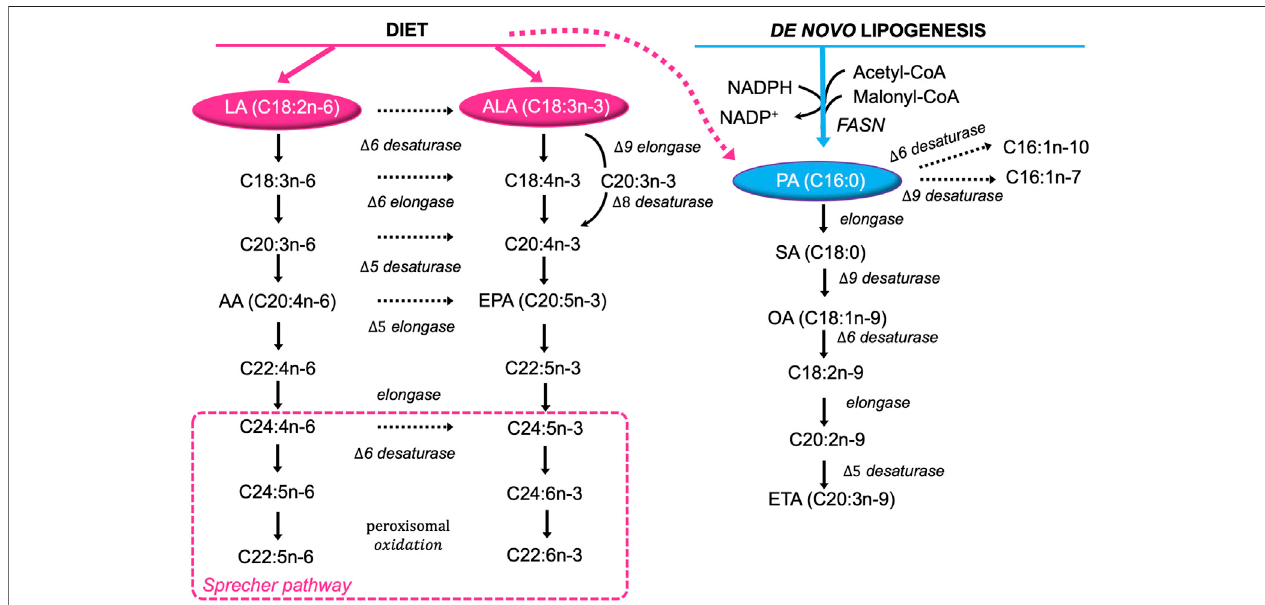
FIGURE 1 | Major pathways of FA desaturation and chain elongation in eukaryotic cells. Both exogenous (diet, pink) and endogenously synthetized FA (blue) are extensively desaturated and elongated giving rise to the huge diversity found in lipid molecules. Note the alternating sequence of desaturation in the horizontal direction and chain elongation in the vertical direction in the formation of polyunsaturated fatty acids from dietary essential fatty acids. LA, linoleic acid; ALA, α -linolenic acid; C18: 4n-3, stearidonic acid; C18:3n-6, γ -linolenic acid; C20:3n-3, eicosatrienoic acid; C20:3n-6, dihomo- γ -linolenic acid; C20:4n-3, eicosatetraenoic acid; AA, arachidonic acid; EPA, eicosapentaenoic acid; C22:4n-6, adrenic acid; C22:5n-3, docosapentaenoic acid; C24:4n-6, tetracosatetraenoic acid; C24:5n-6, etracosapentaenoic acid; C24:5n-3, tetracosapentaenoic acid; C24:6n-3, tetracosahexaenoic acid; C22:5n-6, docosapentanoic acid; C22:6n-3, docosahexaenoic acid;PA,palmiticacid;C16:1n-10,sapienicacid;C16:1n-7,palmitoleicacid;OA,oleicacid;SA,stearicacid;C18:2n-9,translinoleicacid;C20:2n-9,5,11-eicosadienoic acid; ETA, cis-5,8,11-eicosatrienoic